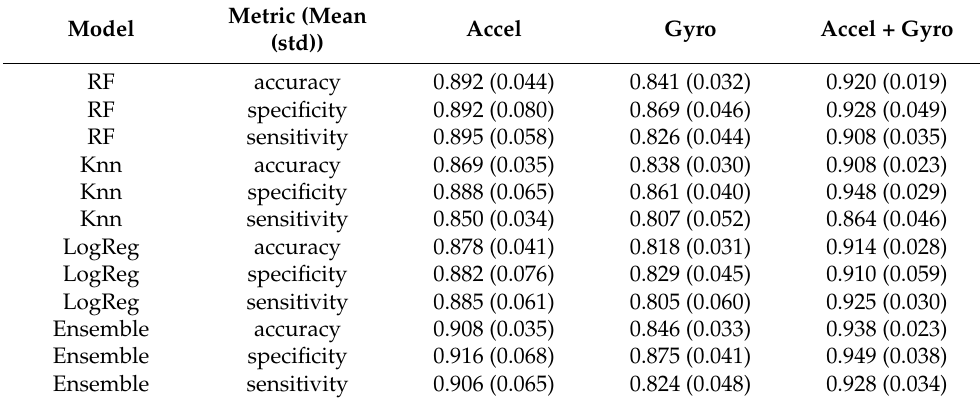
Figure 6. ( A ) Stair walking vs. gait classification was able to achieve the highest performance accuracy using an Ensemble voting classifier model trained on features of the accelerometer and gyroscope signal; however, this accuracy has minimal difference compared to the accelerometer based Ensemble model. ( B ) Stair ascending vs. descending classification was able to achieve the highest performance accuracy using an Ensemble voting classifier model trained on features of the accelerometer and gyroscope signal; however, this accuracy has minimal difference compared to the accelerometer based Ensemble model. Table 1. Stair walking vs. gait classifier